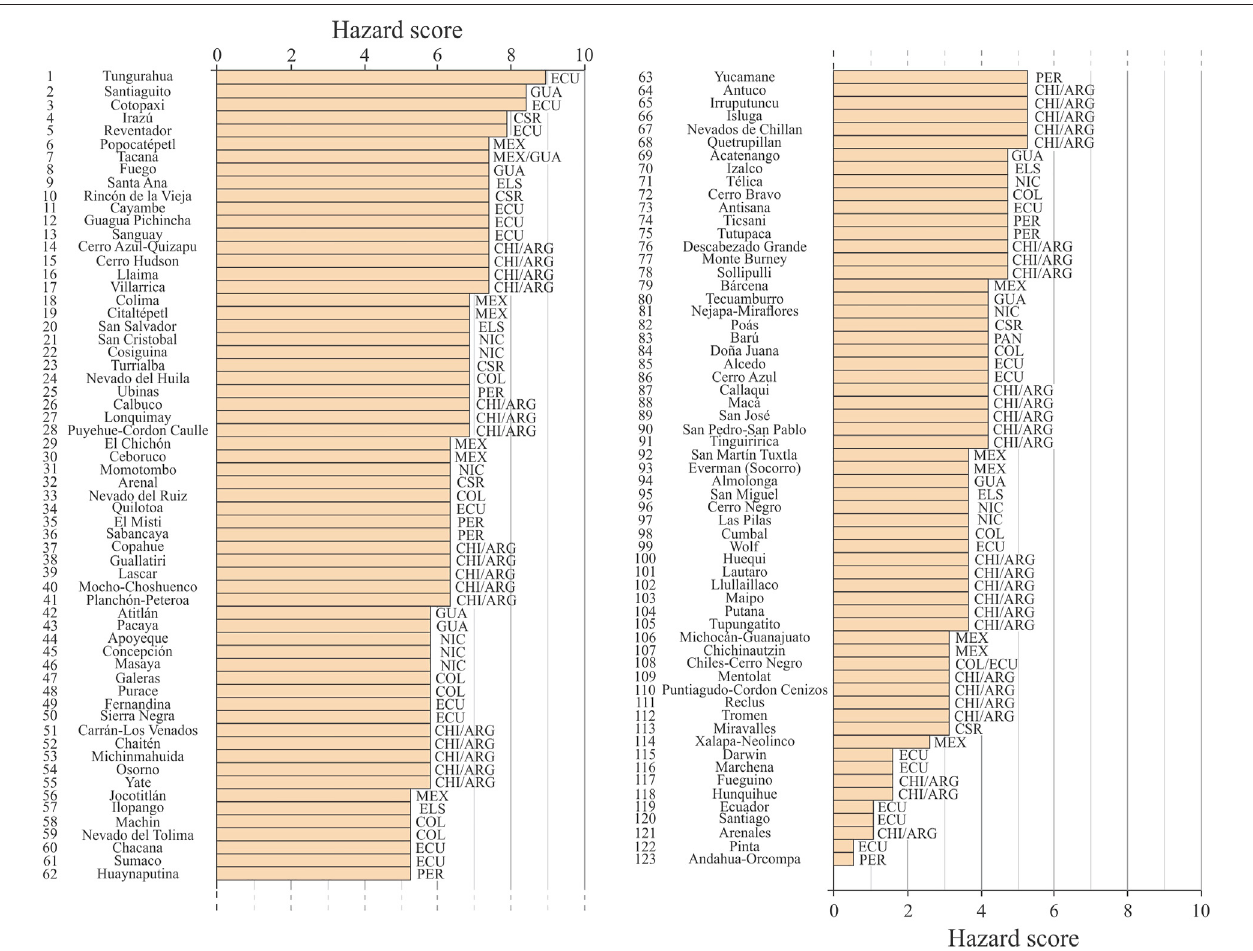
FIGURE 4 | Latin America volcanic systems with recorded activity in the past 1,000 years assessed based on their hazard score. CHI/ARG: Chile/Argentina; COL: Colombia; CSR: Costa Rica; ECU: Ecuador; ELS: El Salvador; GUA: Guatemala; MEX: México; NIC: Nicaragua; PER: Peru.